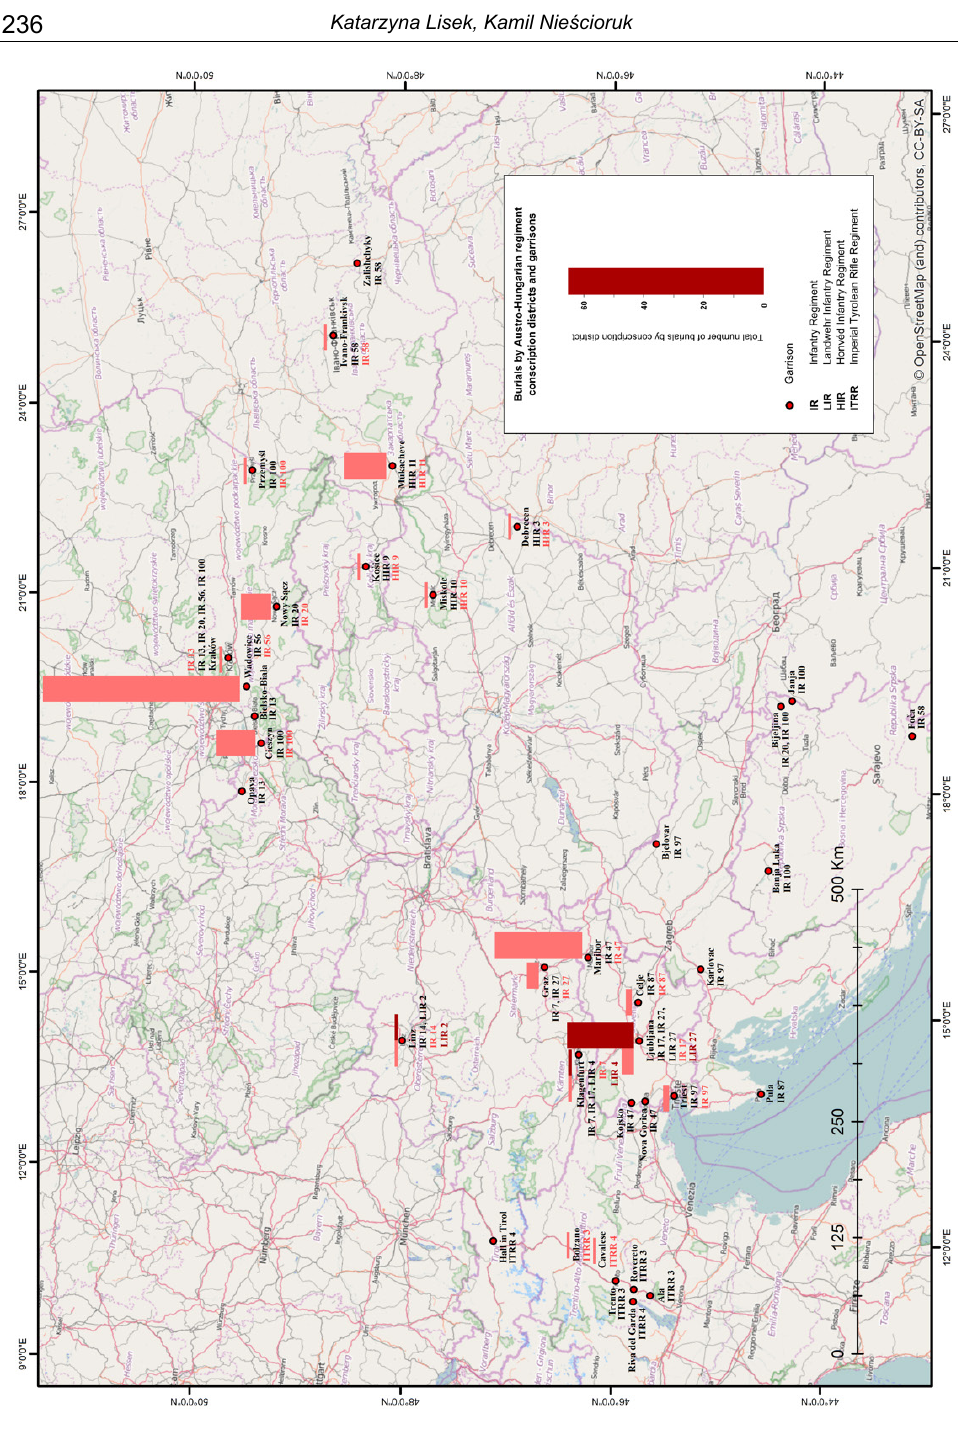
Fig. 8. Buried soldiers of the Austro-Hungarian army by conscription and